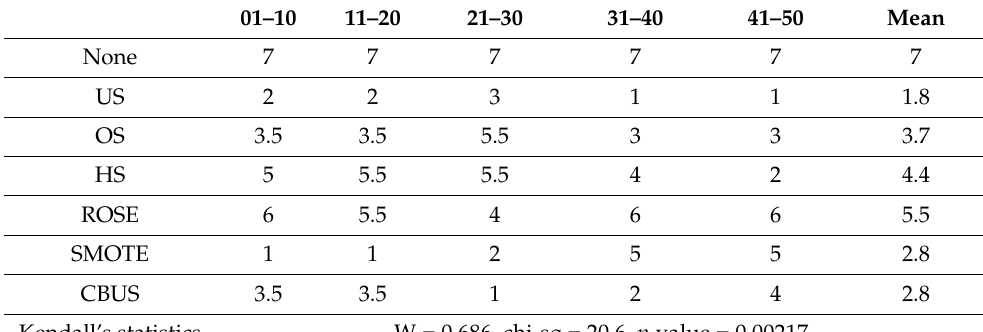
Table 18. Ranks of DBT for NB classifier for varying levels of IR.